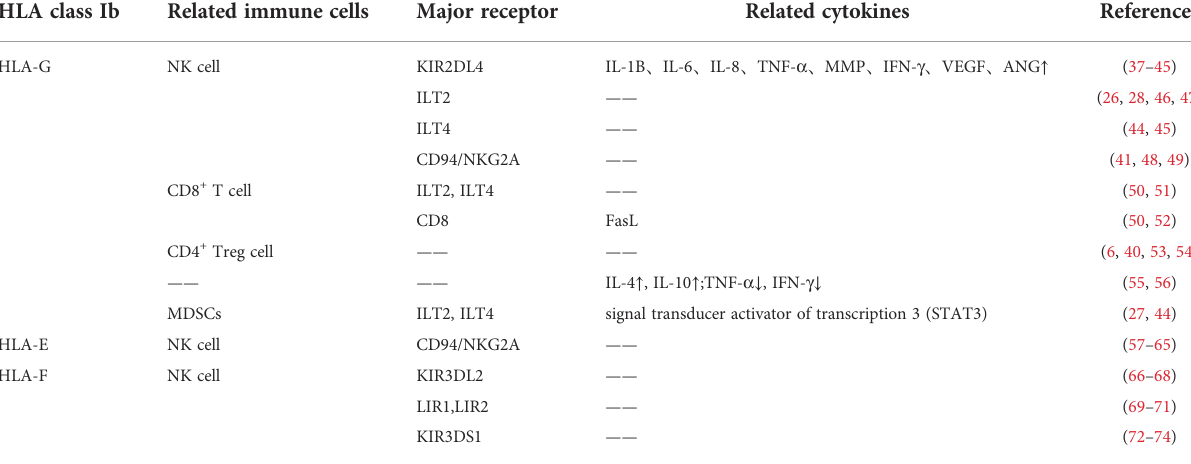
TABLE 1 The recent studies of HLA class Ib in Reproductive